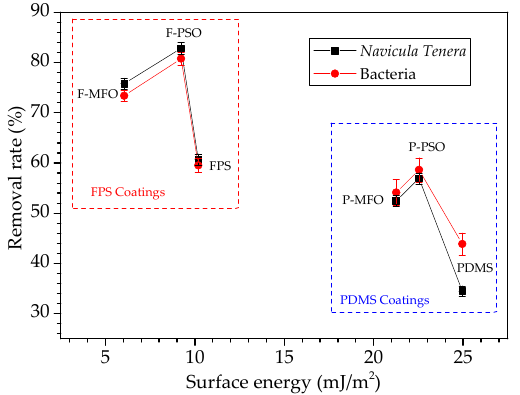
Figure 14. Surface energy vs. biofouling removal rate on studied coatings.